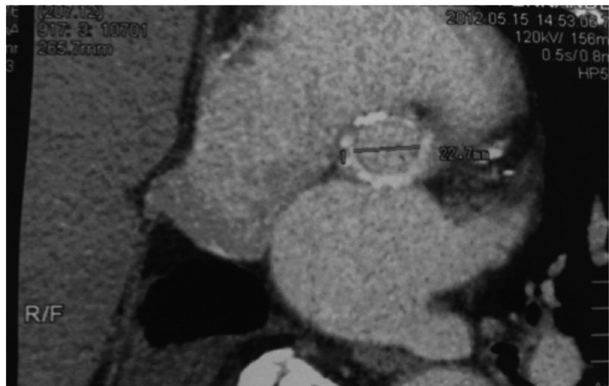
Fig. 1 – Measurement of the valvular ring diameter